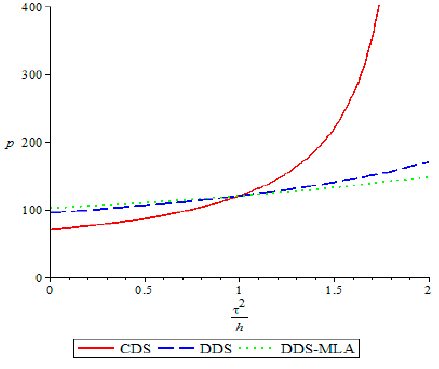
Figure 4. The impact of green efficiency coefficient on retail price.